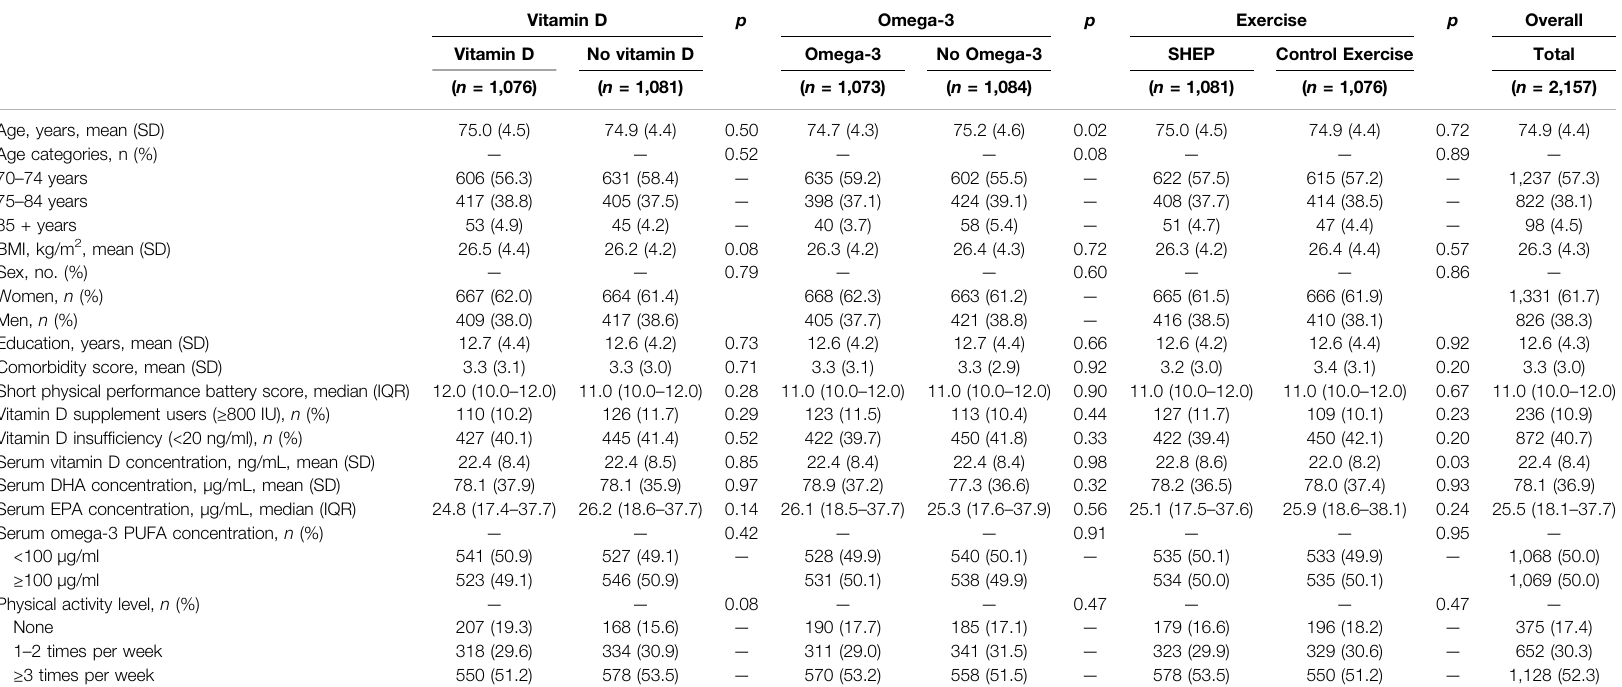
TABLE 1 | Baseline characteristics of the DO-HEALTH trial